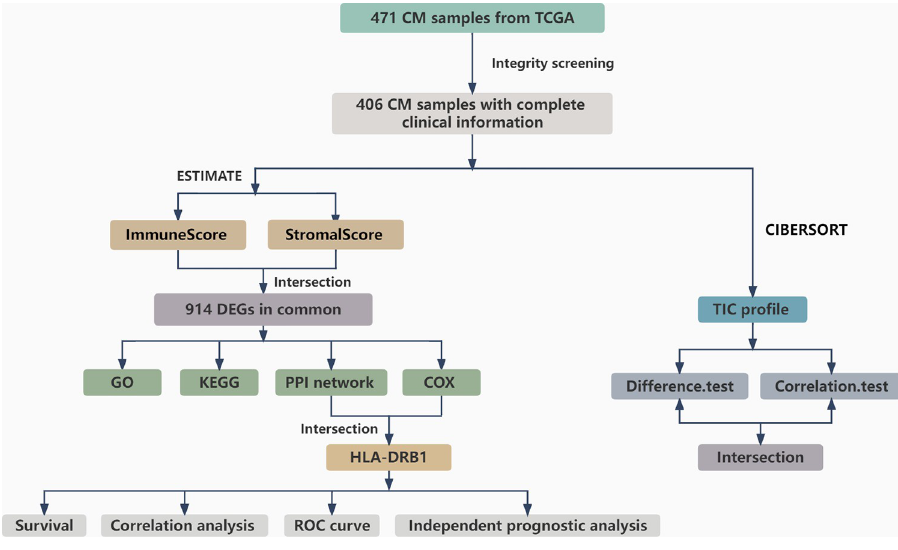
Fig 1. Analysis workflow of this